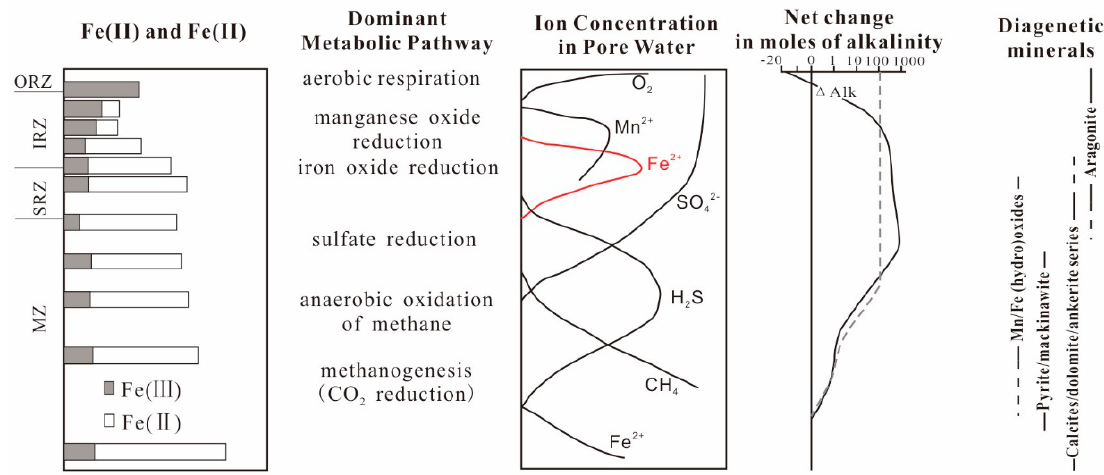
Figure 1. Figure 1. Schematic diagram of a microbial functional group zoning and Fe(III) mineral distribution [46,57].